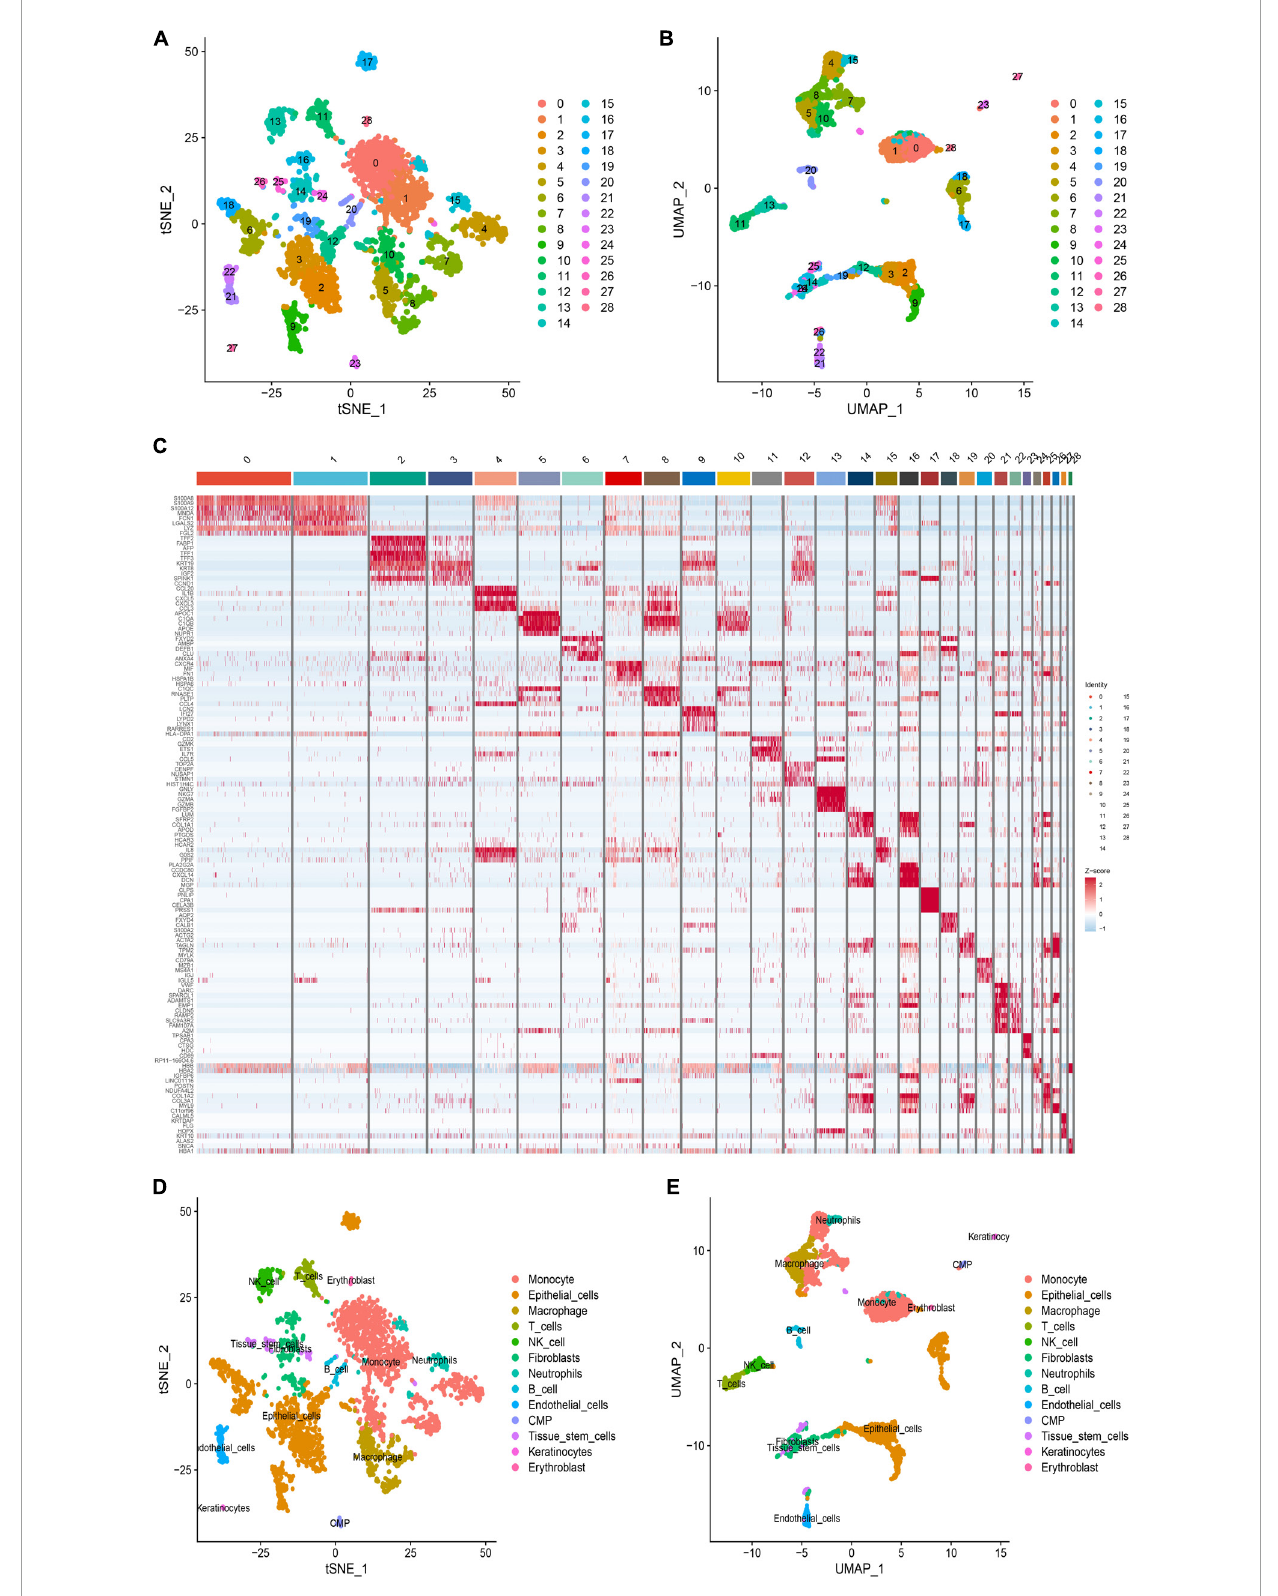
FIGURE2 Heterogeneity analysis of ruptured aortic aneurysms. (A) Distribution map of t-distributed stochastic neighbor embedding (tSNE) clusters. (B) Distribution map of t-distributed stochastic neighbor embedding (tSNE) clusters. (C) Heat map showing the expression levels of 28 subgroup markers. (D) Cell annotation on the tSNE plot. (E) Uniform manifold approximation and projection (UMAP) plots of cell